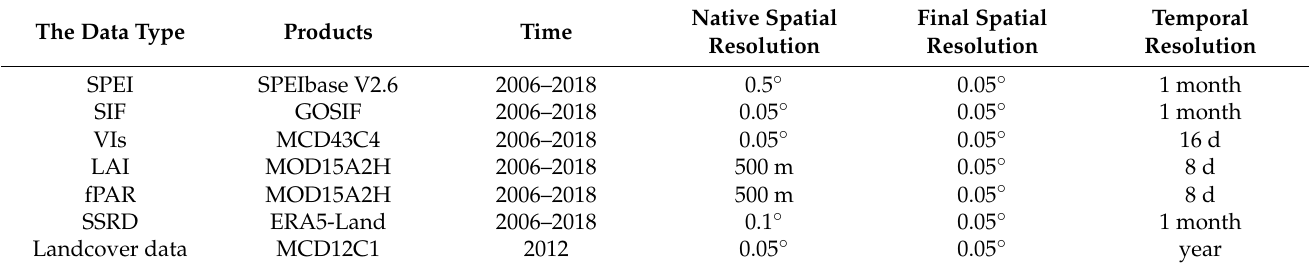
Table 1. Datasets used in the study.